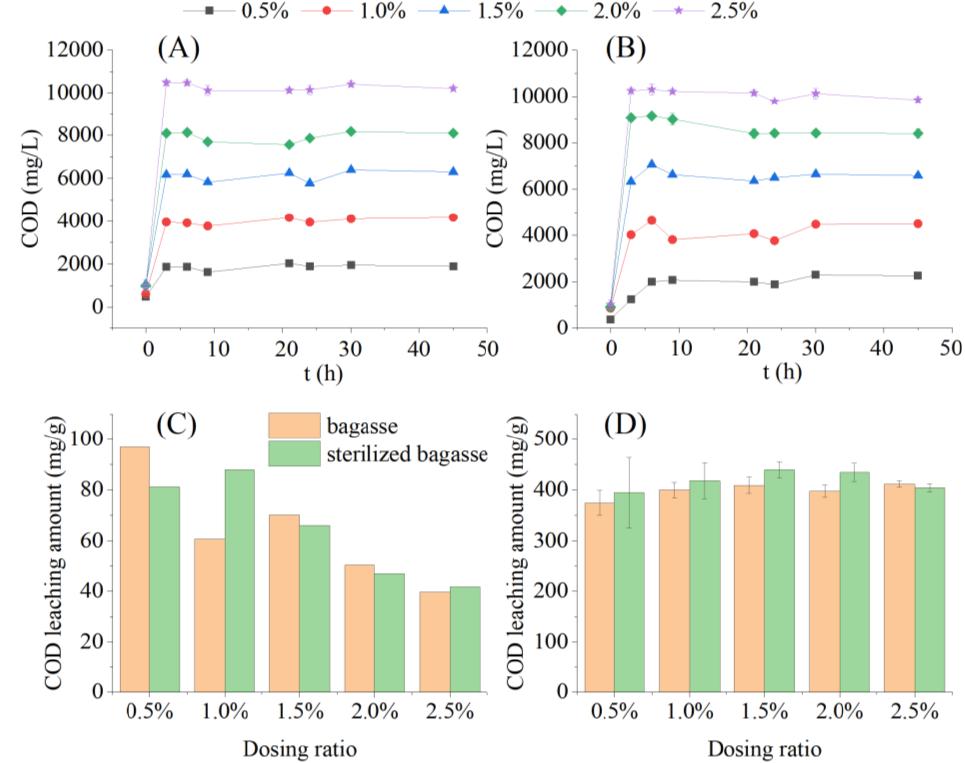
Figure 3. Chemical oxygen demand (COD) release from sugarcane bagasse and sterilized bagasse under different dosing ratios. Note: Error bars in ( D ) indicate the standard deviation of COD leaching from 3 to 45 h. ( A ) COD leaching concentration of bagasse; ( B ) COD leaching concentration of sterilized bagasse; ( C ) COD leaching amount within 3 h; ( D ) COD leaching amount within 3–45 h. The COD leaching concentration and the amount of bagasse under batch water